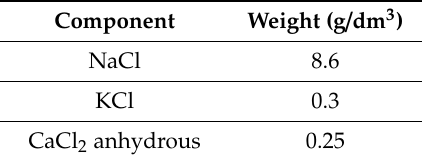
Table 1. The chemical composition of Ringer’s solution.